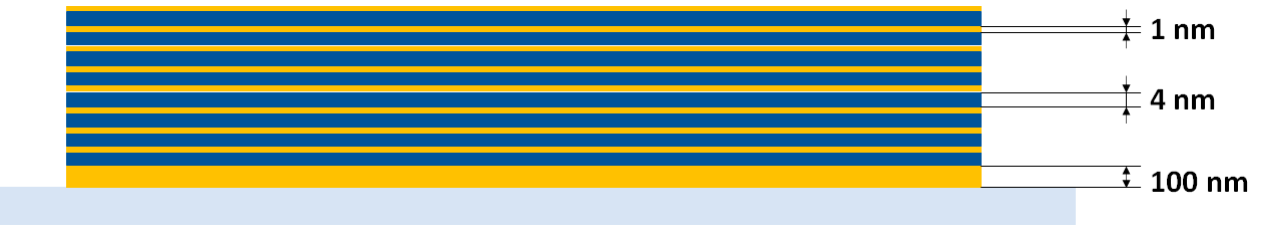
Figure 1. Scheme and dimensions of the structure in the current to plane configuration.